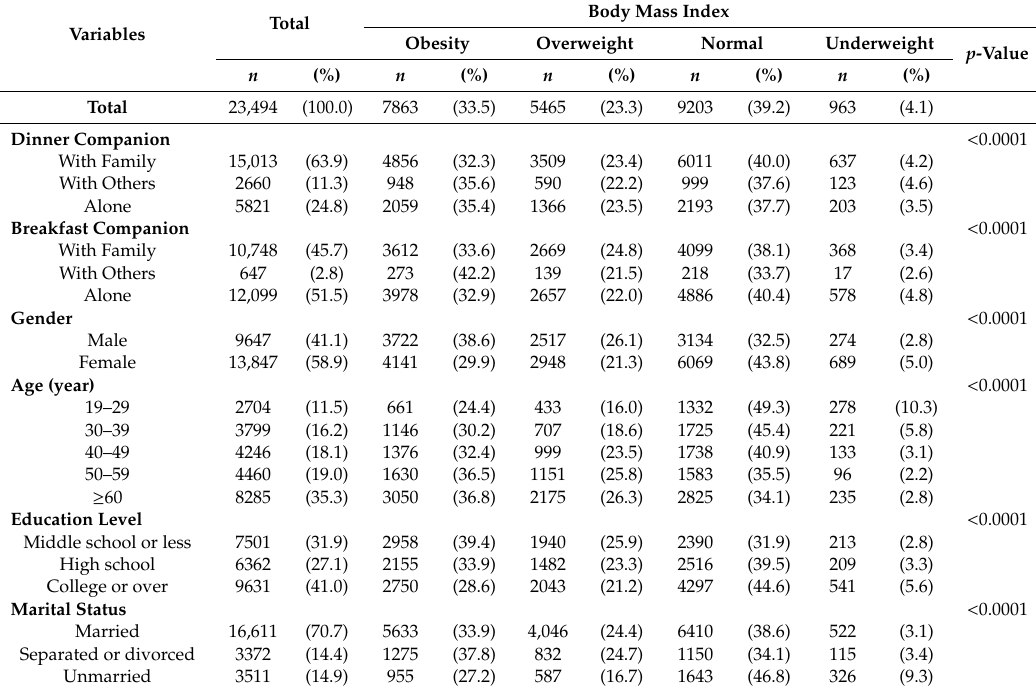
Table 1. General characteristics of study